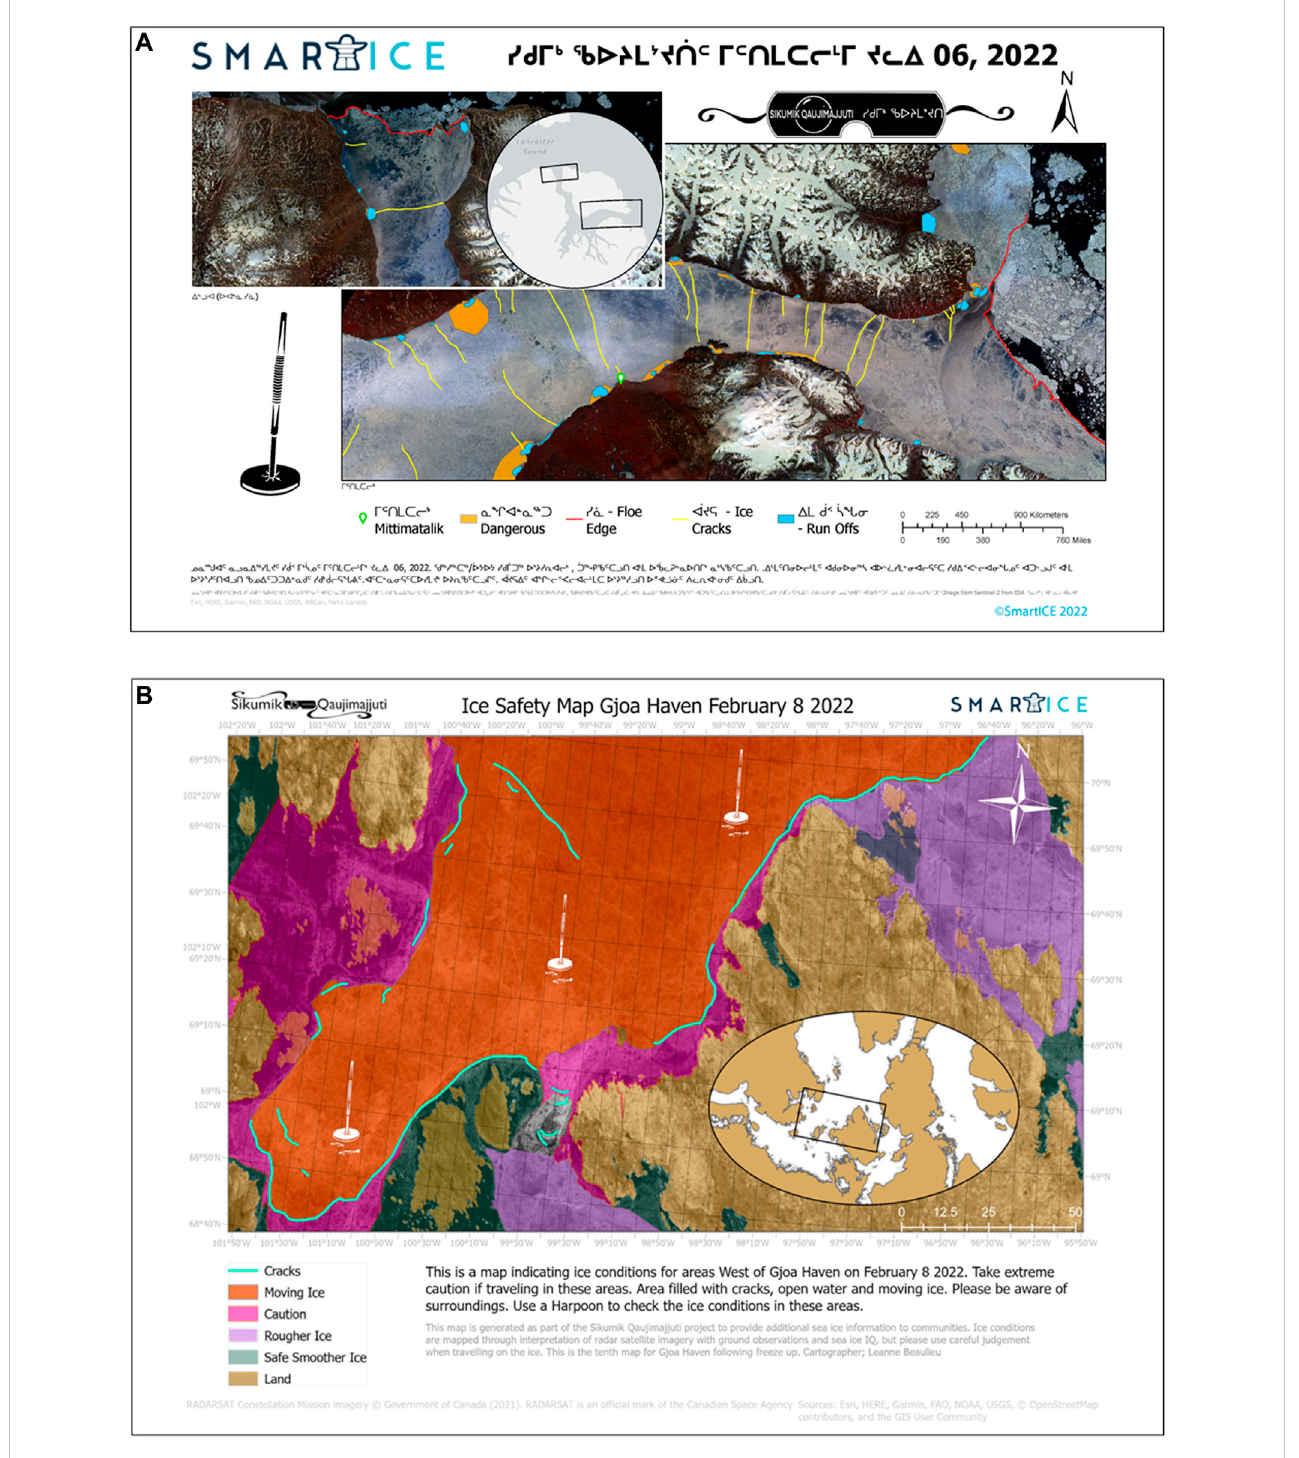
FIGURE 2 Examplesof SikumikQaujimajjuti mapsproducedin2022. (A) .TheJune6thMittimatalik,Nunavut,mapfocussedondangerousrun-offareas,cracks,and the fl oe edge in two locations. The map is produced in both english and inuktitut to respond to the community desire to share the information in both languages (cartographer: A. Arreak) (B) . The February 8th map produced in Gjoa Haven, Nunavut, shows the area to the west of King William Island, where rough and moving ice (orange and purple tones) could make traveling dif fi cult and dangerous (cartographer: L.